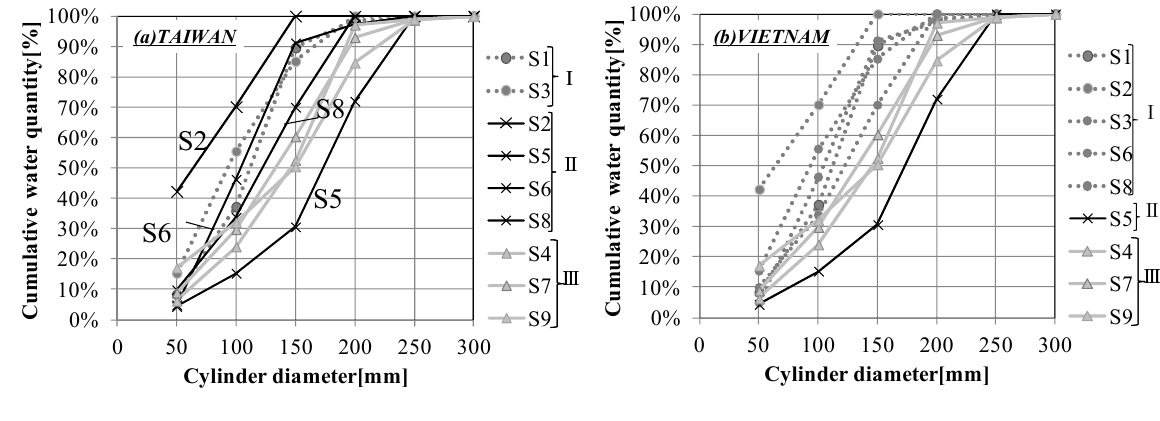
Figure 1. Spray Pattern ( a ) Taiwan; ( b )